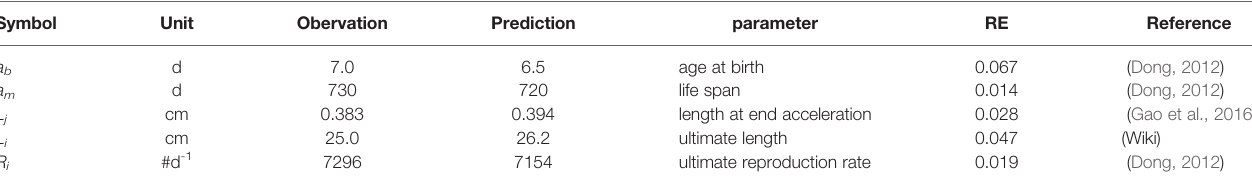
TABLE 2 | Zero-variate data used for estimating parameters of the swimming crab Portunus trituberculatus DEB model. Observed data and relative error (RE) are speci fi ed. Symbol